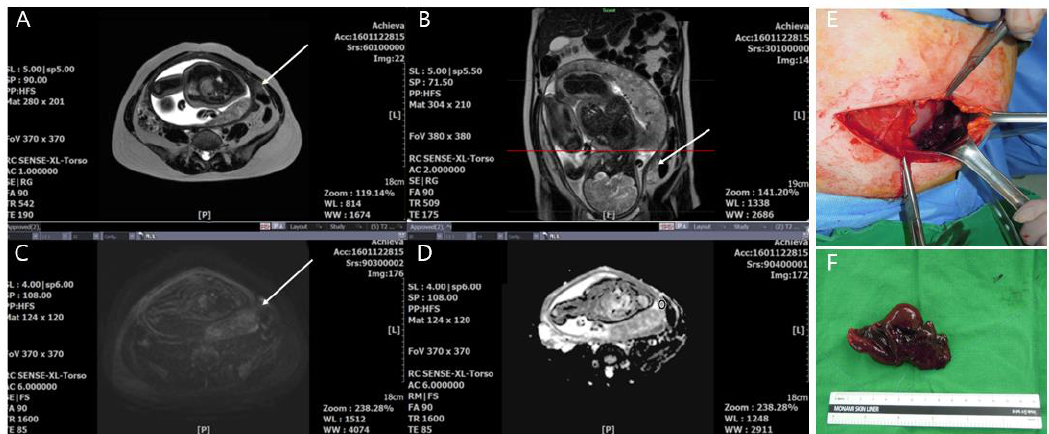
Figure 3. A 34-year-old pregnant woman (35.2 weeks) with acute salpinx torsion with hemorrhagic infarction in the salpingectomy group. ( A ), ( B ) Transaxial and sagittal T2-weighted fast spin-echo MR images show slightly swollen ovary (not seen in this figure) and hyperintense fallopian tube or fimbriae (arrow). ( C ) Transaxial diffusion-weighted MR image shows heterogenous slightly hyperintense swollen fallopian tube (arrow). ( D ) Apparent diffuse coefficient (ADC) map shows diffusion restriction of fallopian tube or fimbriae (arrow). ADC value in a circle indicating the region of interest (ROI) placed in fallopian tube or fimbriae was 0.96 ± 0.13 × 10 −3 mm 2 /s. ( E ), ( F ) Intraoperative photograph reveals a necrotic fallopian tube or fimbriae (arrowhead) under laparotomy. (Color version of the figure).